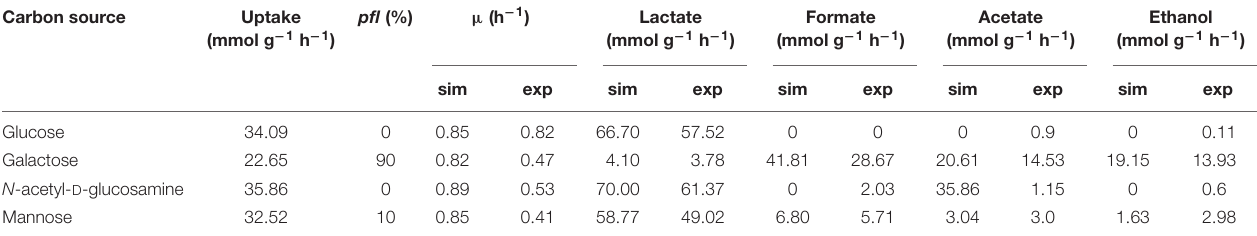
TABLE 5 | Growth and by product analysis with the i DS372 model, using different (optimized) levels of pfl expression for the four different carbon sources tested (glucose, galactose, N -acetyl- D -glucosamine, and mannose). Carbon